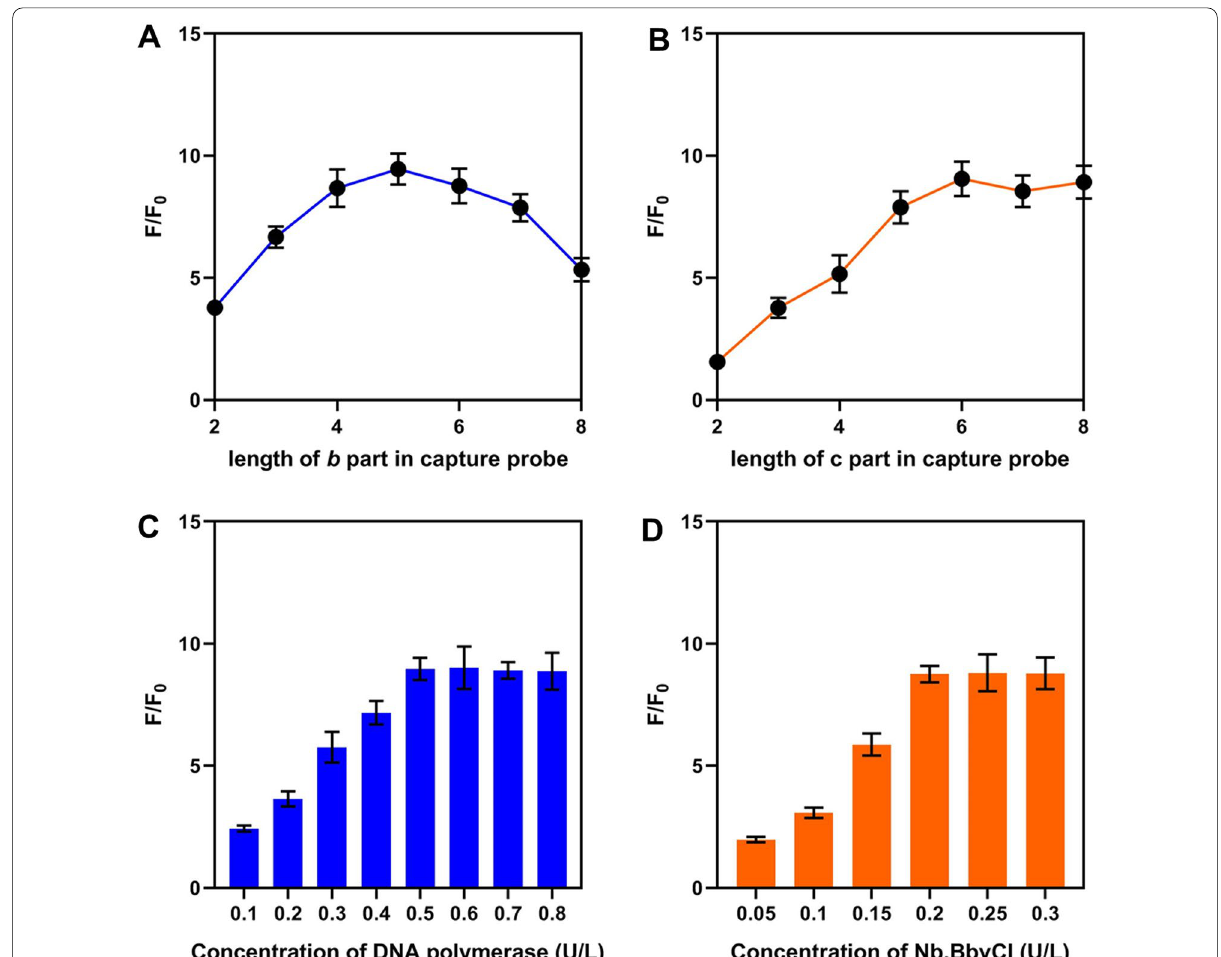
Fig. 3 Optimizations of experimental parameters. a F/F0 result of the approach with different lengths of b part in capture probe; b F/F0 result of the approach with different length of c part in capture probe; F/F0 result of the approach with different concentration of DNA polymerase ( c ) and Nb.BbvCI ( d